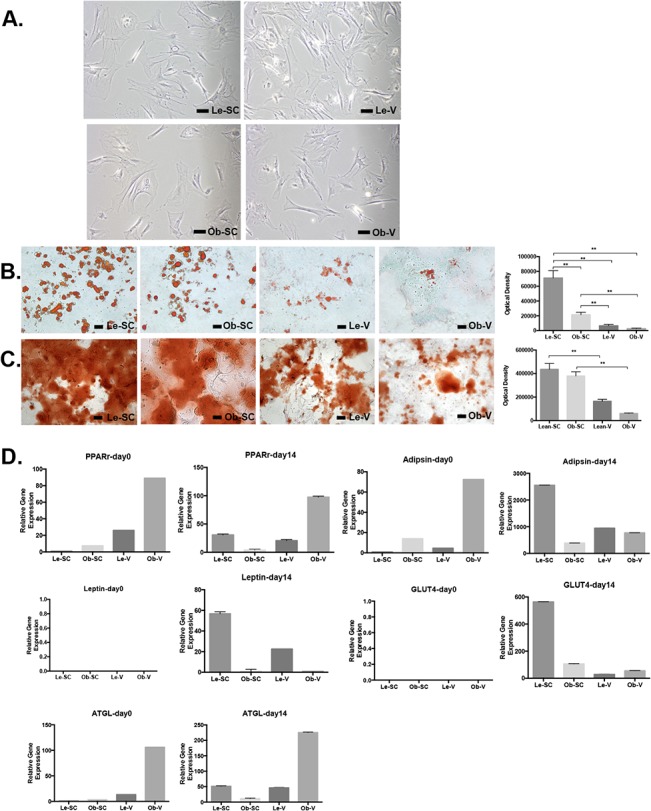
Characterization of SC-ASC and V-ASC from obese and lean mice.
A, Morphology of adherent cells showing similarity of SC-ASC and V-ASC from obese and lean mice. Scale bar, 1μm. B, Adipogenesis of SC-ASC and V-ASC. Differentiated cells were stained with oil red-O and quantified by percentage of pixels of oil red-O in images. Error bars, SEM. **, P < 0.01(Mann-Whitney test). Scale bar, 100μm.C, Osteogenesis of SC-ASC and V-ASC. Differentiated cells were stained with alizarin red S. Error bars, SEM. **, P < 0.01(Mann-Whitney test). Scale bar, 100μm. D, Quantitative RT-PCR analysis of mRNA levels for genes hallmarking adipocyte differentiation and lypolysis normalized to 18s RNA expression in indicated ASC at baseline and 14 days after adipogenesis induction. Error bar: SEM.